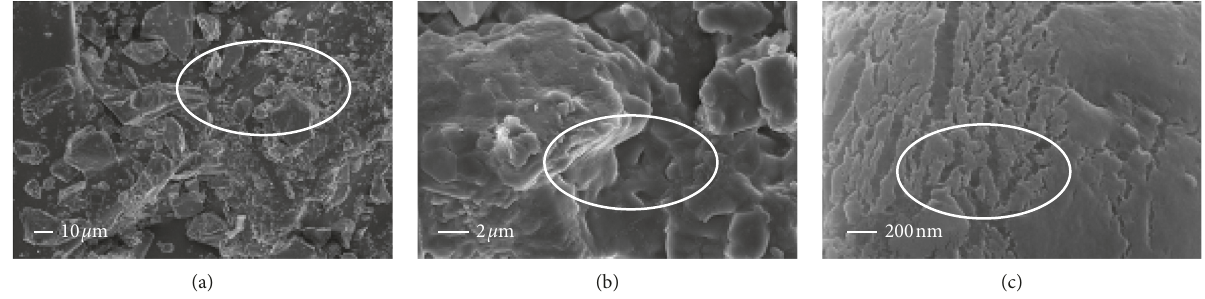
Figure 5: The images of KNO 3 (44.62%)/NaNO 3 (52.38%)/graphite (3.00%).